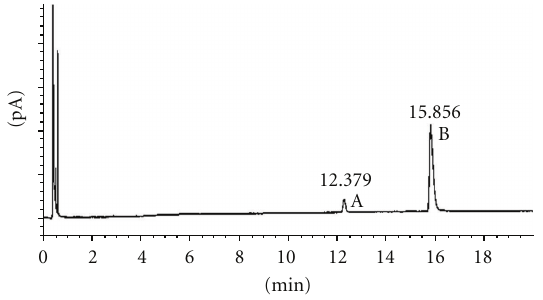
Figure 4: Chiral GC analysis of the trans - R , R -1,2-cyclohexanediol acetates: (A): trans - R , R -2-hydroxycyclohexyl acetate; (B) trans - R , R - 1,2-cyclohexanediol.